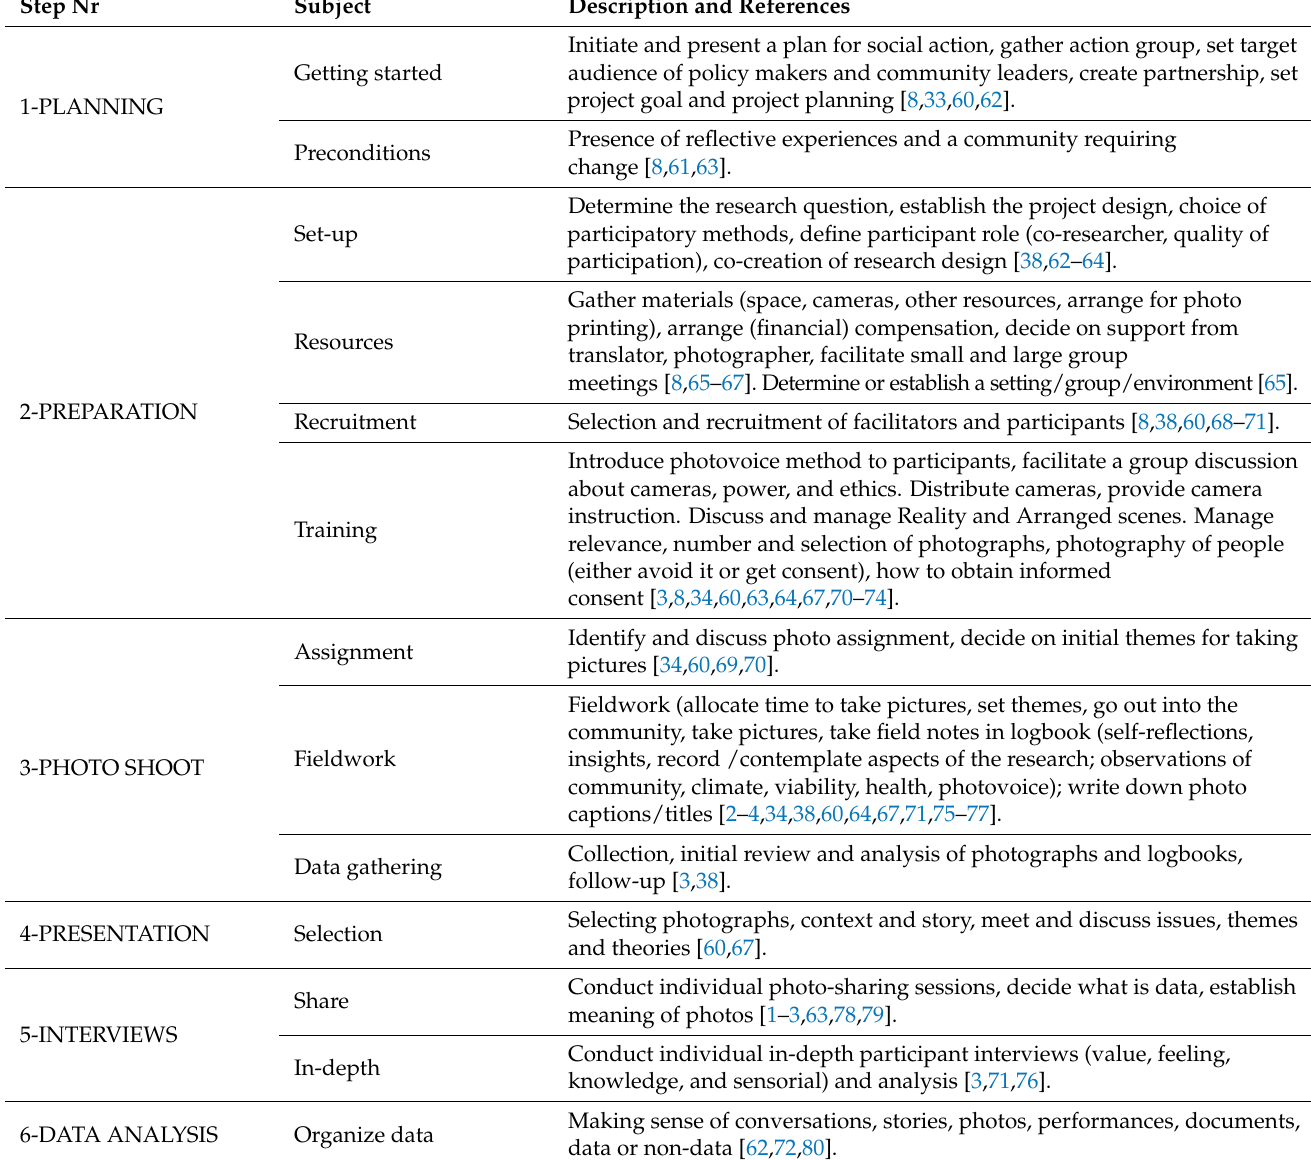
Table 2. Common process steps observed in photovoice projects with